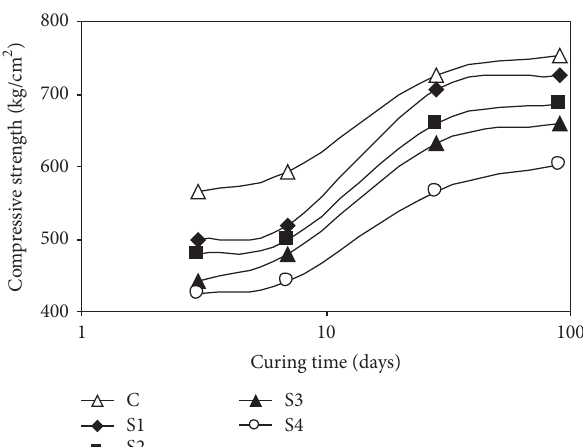
F 3: e compressive strength of sewage sludge ash blended cement pastes.